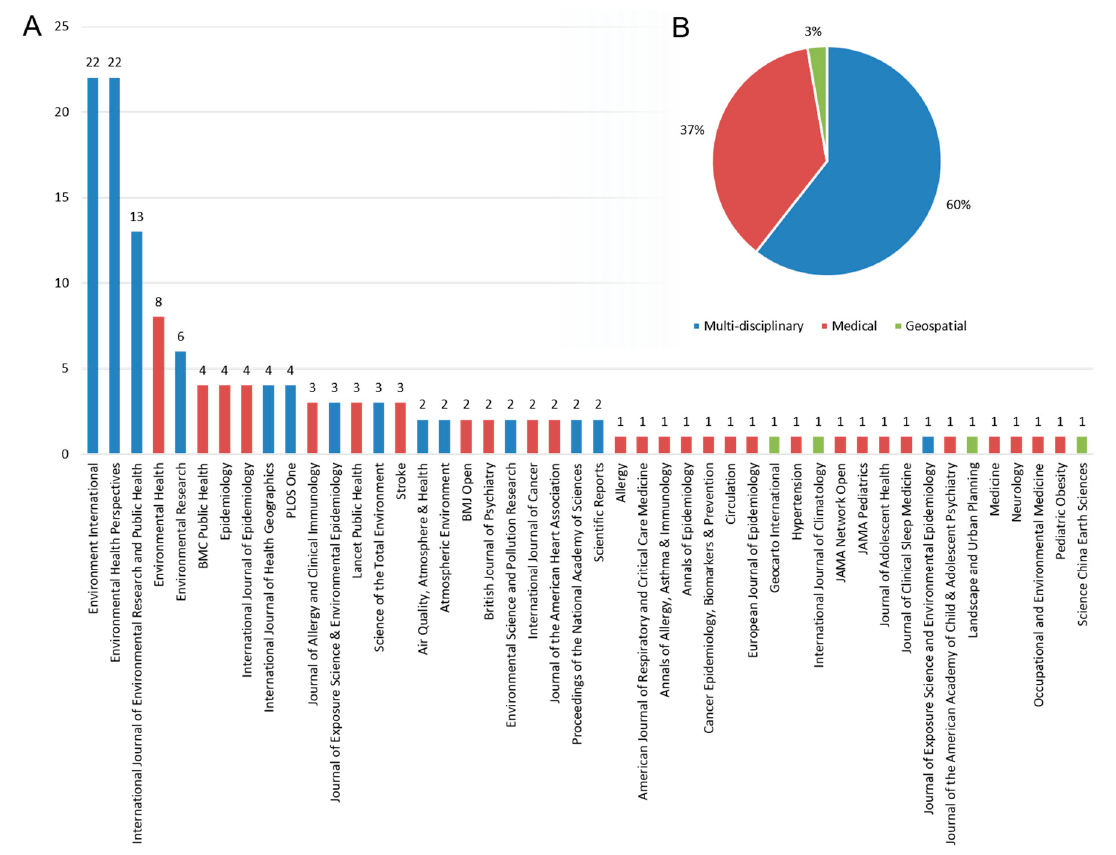
Figure 5. ( A ) Absolute number of articles per journal with indication of research focus. ( B ) Shares of research categories of reviewed articles in absolute numbers and relative values.